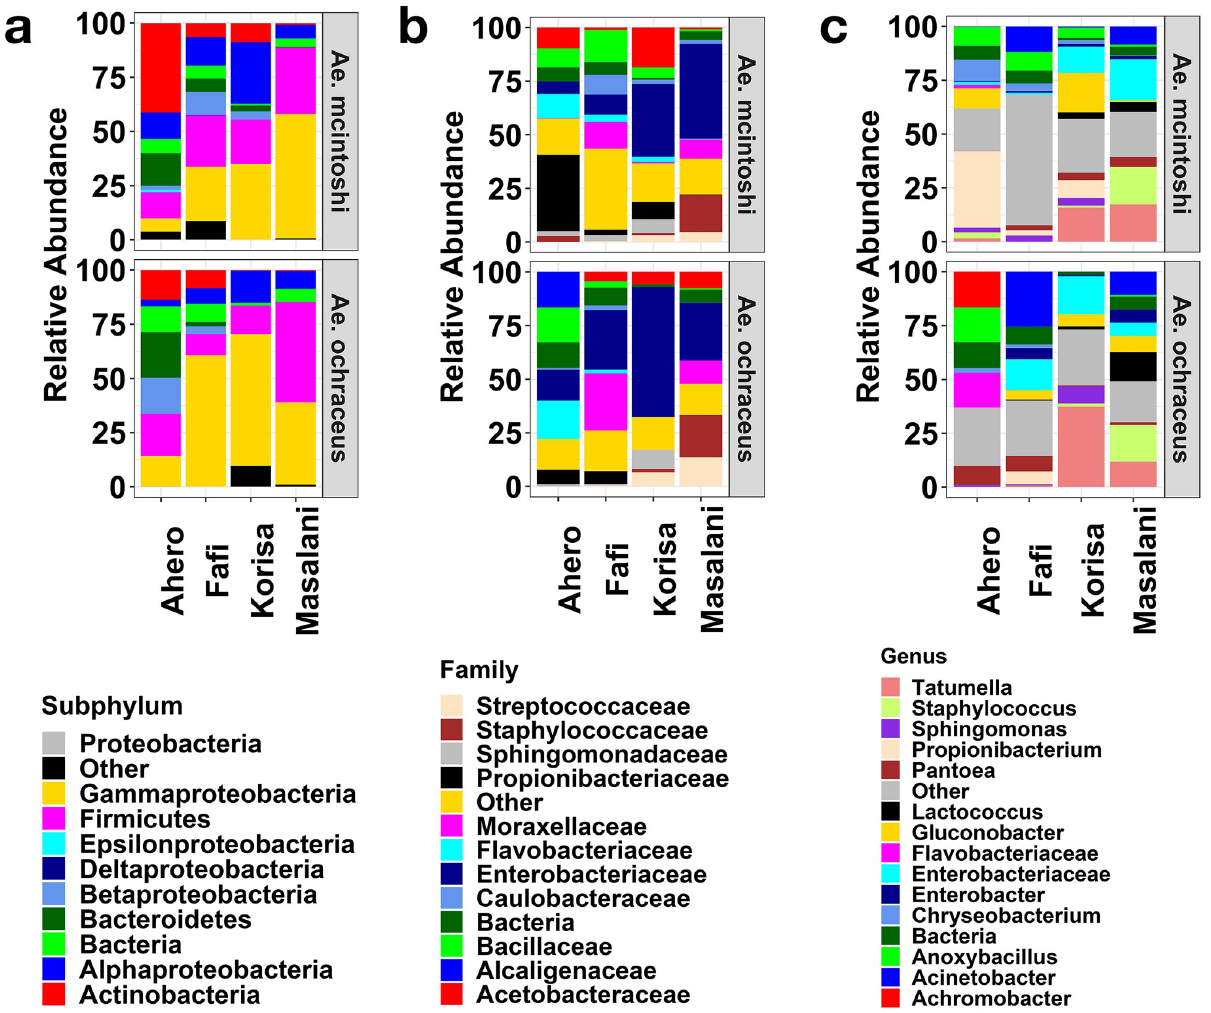
Fig 5. Mean relative abundances of bacterial OTUs associated with Aedes mcintoshi (upper panel) and Aedes ochraceus (lower panel) from the different study sites at the A) subphylum, B) Family and C) genus levels. Families and genera accounting for less than 2% of the total sequences were pooled as